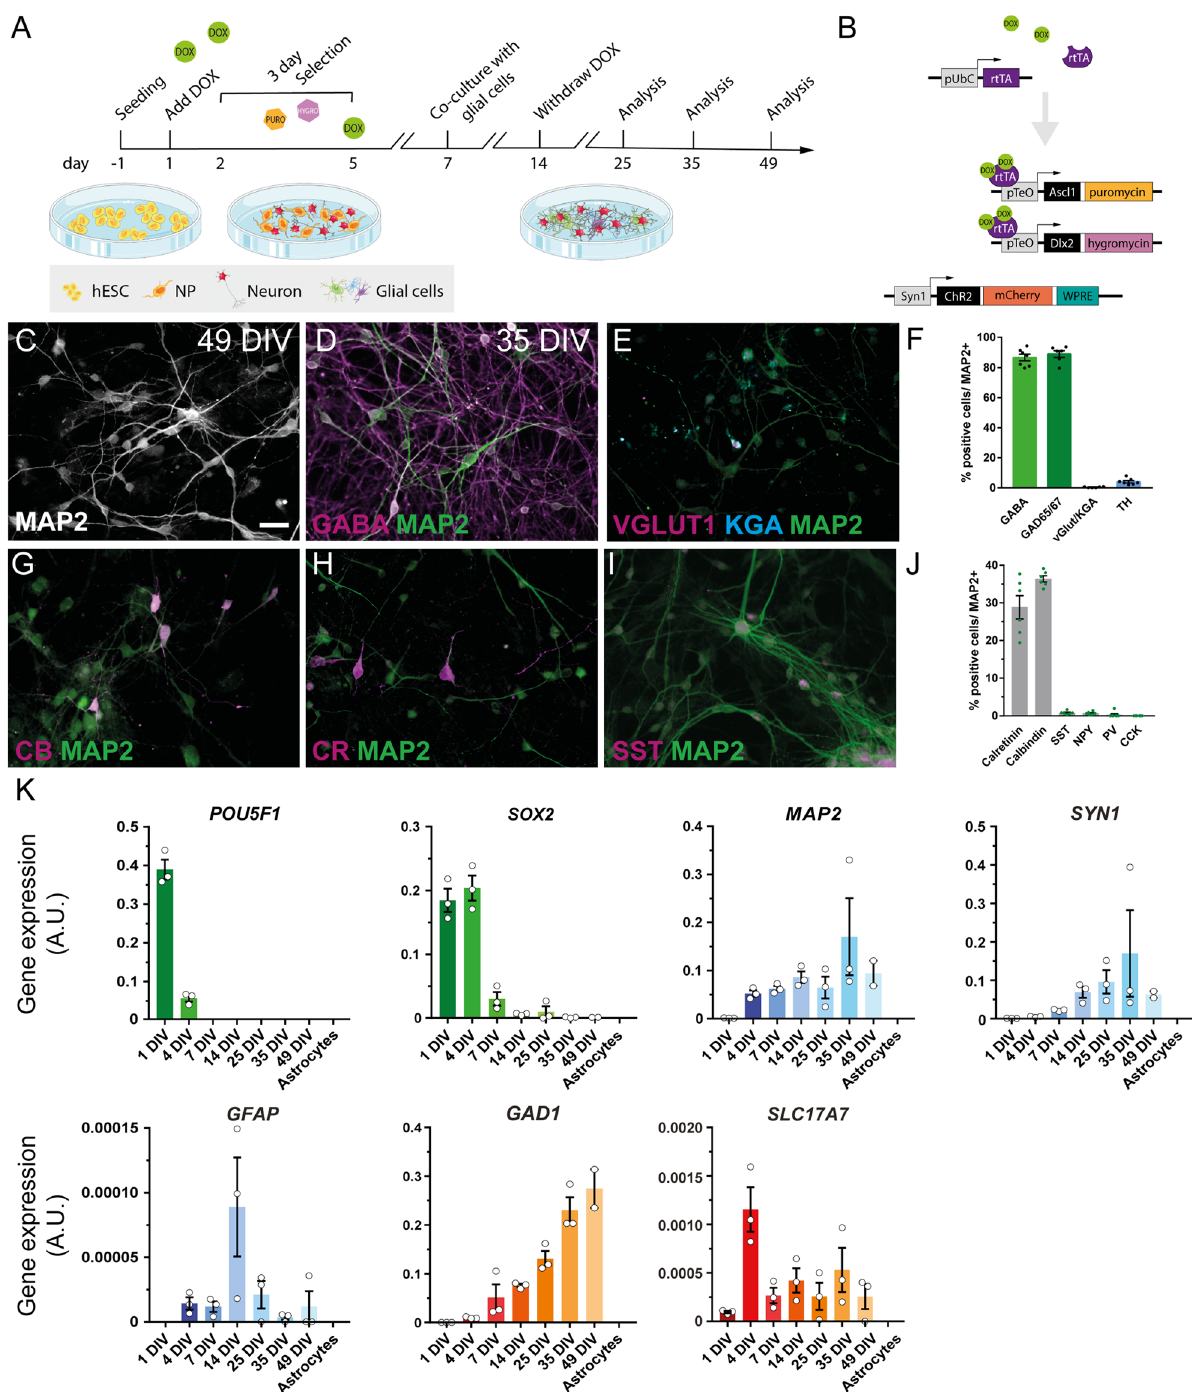
Figure 1. Transgene expression of the transcription factors Ascl1 and Dlx2 by Tet-On system triggers the differentiation of hESC to GABAergic neurons. ( A ) Differentiation protocol used for the generation of hdINs. ( B ) Schematic view of the constructs carried by the lentiviral particles used in the differentiation protocol (Tet-On system), and for the expression of ChR2. ( C ) Immunocytochemistry for the neuronal marker MAP2 + of the derived neurons at 49 DIV. ( D , E ) Immunocytochemistry of hdINs at 35 DIV for GABAergic (GABA) and glutamatergic (VGLUT1 and KGA) markers. ( F ) Quantification of the percentage of GABA +, GAD65/67 +, vGlut1 +/ KGA + and TH + cells over MAP2 + cells as an average of both time points, 35 and 49 DIV. ( G – I ) Representative images of hdINs showing the presence of the interneuron markers CB, CR, and SST. ( J ) Quantification of the percentage of CR +, CB +, SST +, NPY +, PV + and CCK + subtypes over MAP2 + cells. ( K ) Gene expression profile during the differentiation. Values for the pluripotency gene POU5F1 that encodes for OCT4, and SOX2 gene in green. Genes expressed in mature cell populations such as MAP2 and SYN1 in neurons, and human GFAP in astrocytes where also analyzed and indicated in blue. Key genes of the two main neuronal populations in the brain were also studied and shown in orange, quantifying GAD1 gene which is expressed in GABAergic neurons and SLC17A7 gene which encodes for VGLUT1 and it is expressed in glutamatergic neurons. NP, neural precursor. Scale bar: 100 µm. Mean ± SEM. Schematics were generated and adapted using resources from Servier Medical Art 35